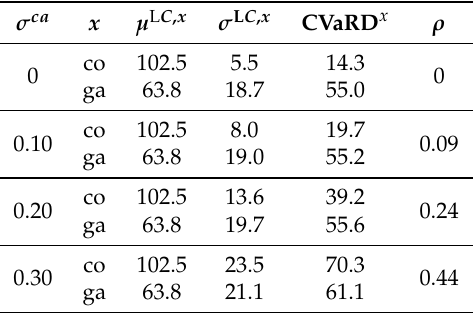
Figure A2. LCOE distributions in the σ ca = 0.2 scenario. Left panel: P LC,co ( ω ) . Right panel: P LC,ga ( ω ) . Table A4. First two central moments and CVaRD values of the P L C , x (LCOE) distribution. σ